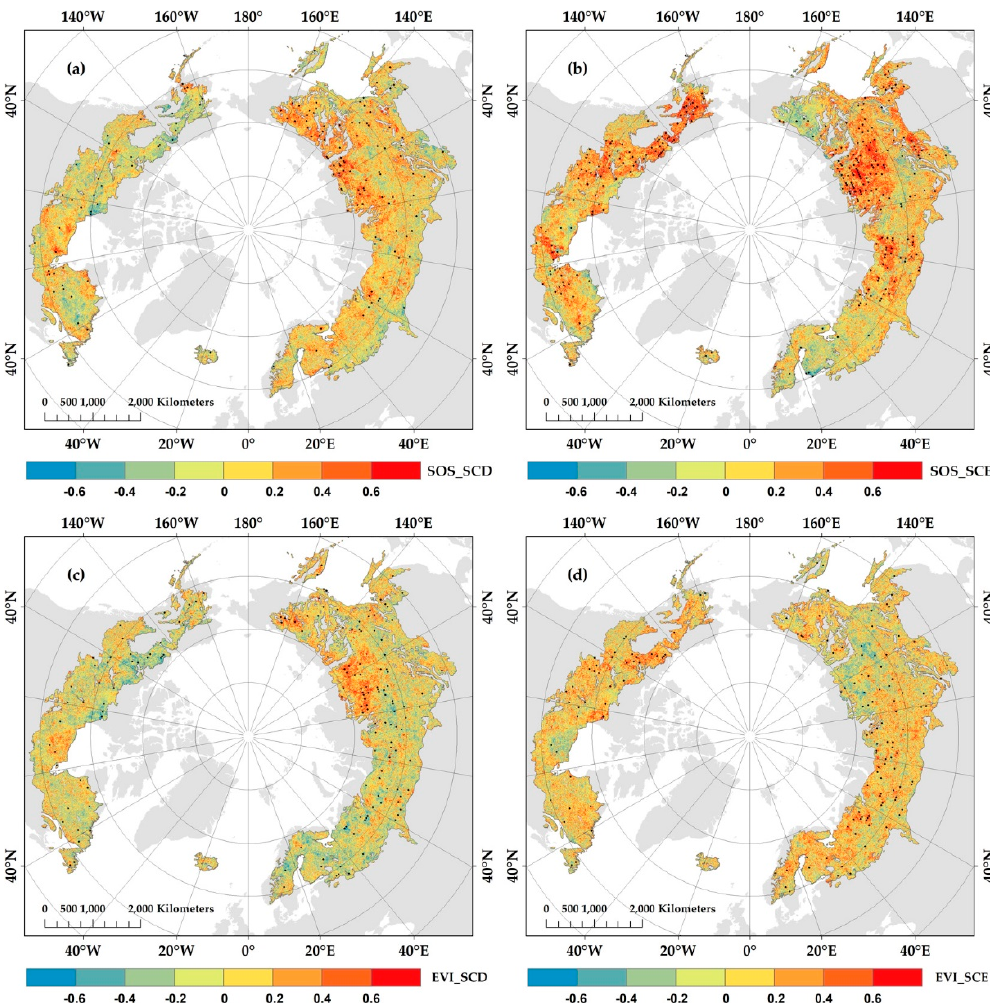
Figure 5. Spatial distribution of the partial correlation coefficient between ( a ) the start of growing season (SOS) and snow cover duration (SCD); ( b ) start of growing season (SOS) and snow cover end date (SCE); ( c ) annual maximum enhanced vegetation index (EVI max ) and snow cover duration (SCD); ( d ) annual maximum enhanced vegetation index (EVI max ) and snow cover end date (SCE). The dotted regions indicate correlations that were significant at the 95% level.